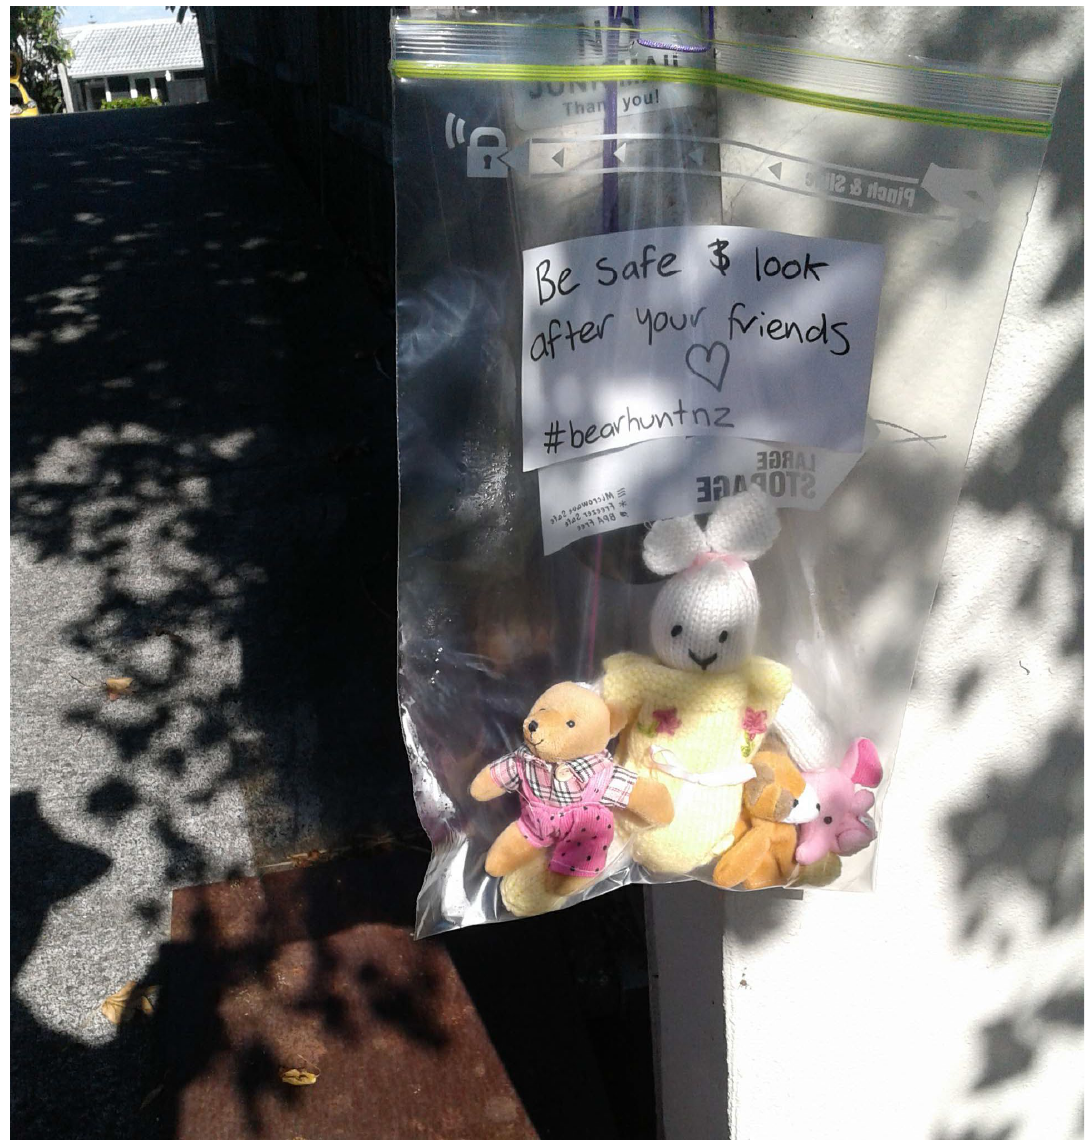
Figure 2 . Sometimes ‘bears in windows’ didn’t make it into an actual window. These were displayed in a plastic bag nailed on to a mailbox post, tagged #bearhuntnz. Image by the